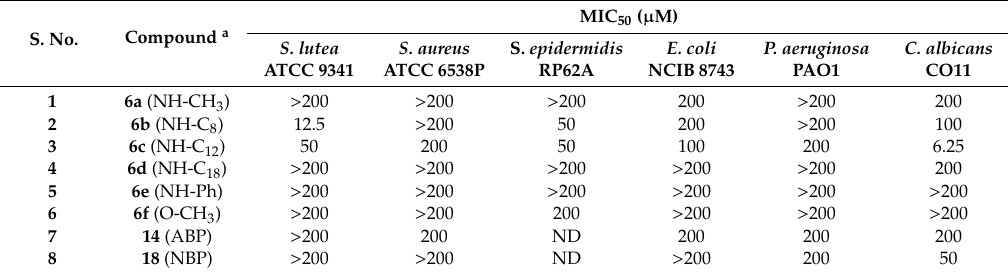
Table 2. MIC 50 values of all aaSA analogues against di ff erent microorganisms.